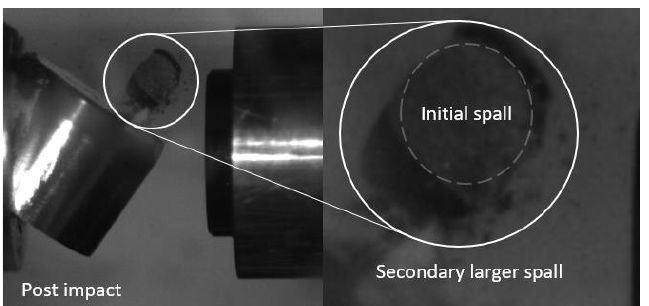
Fig. 6. Post impact image of the cutter that failed catastrophically with zoom to show both the initial and secondary